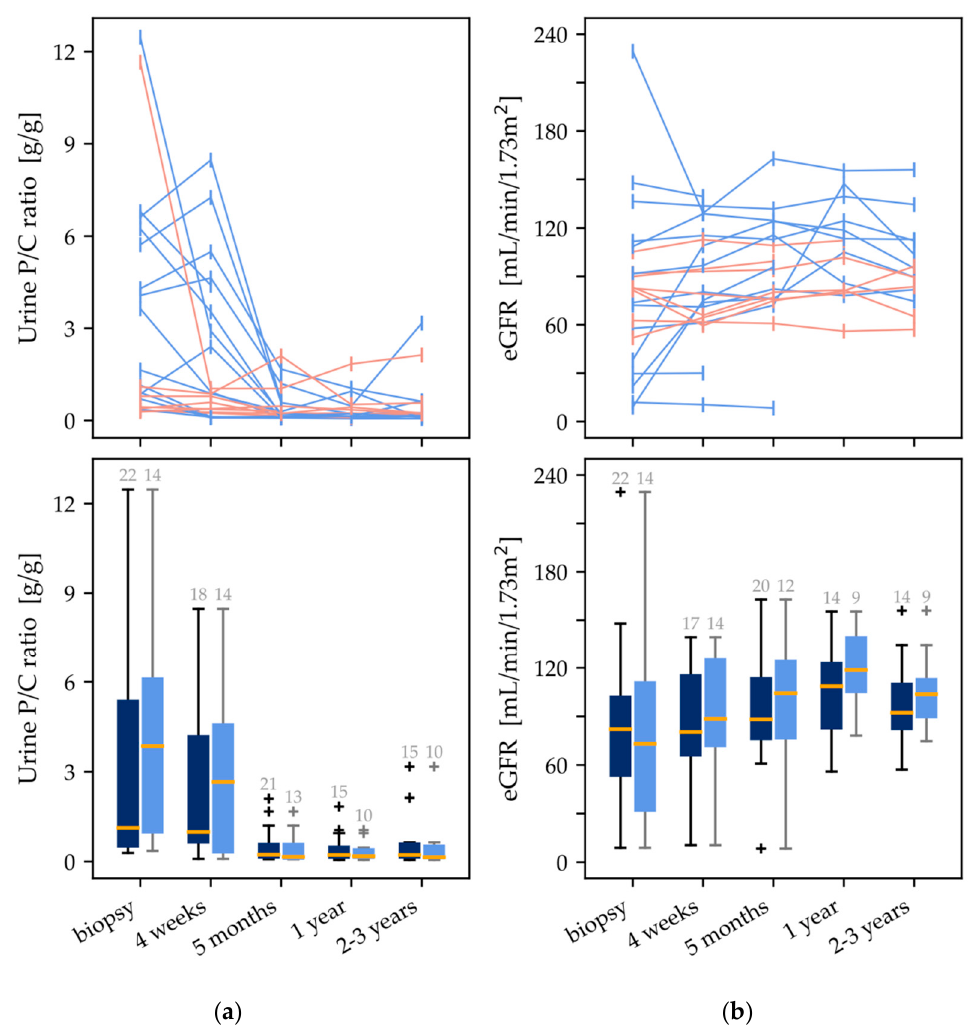
Figure 1. Follow-up data for five points in time: ( a ) urine protein to creatinine ratio (P/C) in g/g; ( b ) eGFR (mL/min/1.73 m²). The blue lines represent patients who received i.v. corticosteroid therapy, and the orange lines represent those without. The boxplots below show the data for all patients (dark blue) and for the proportion of patients who received i.v. corticosteroids (light blue). The box-plot outliers are represented by the symbol “+”.